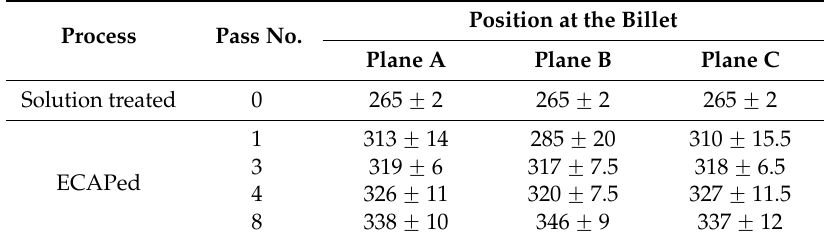
Table 2. Average microhardness values at different planes for the solution-treated and ECAP processed